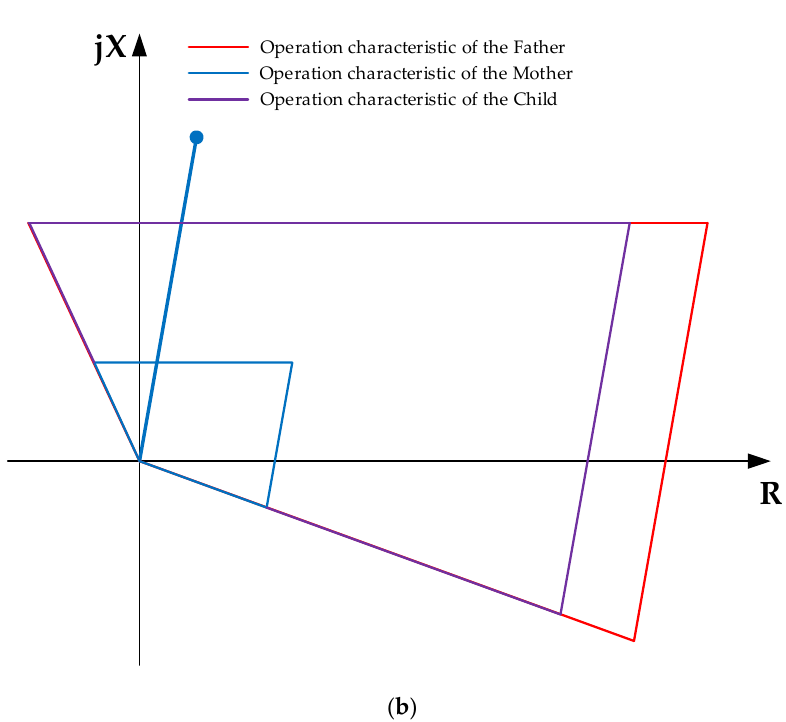
Figure 9. Crossover examples for ( a ) crossover rate equal to 1.0 and β equal to 0.8, and ( b ) crossover rate equal to 0.5, Rreach selected as variable to be crossed and α equal to 1.